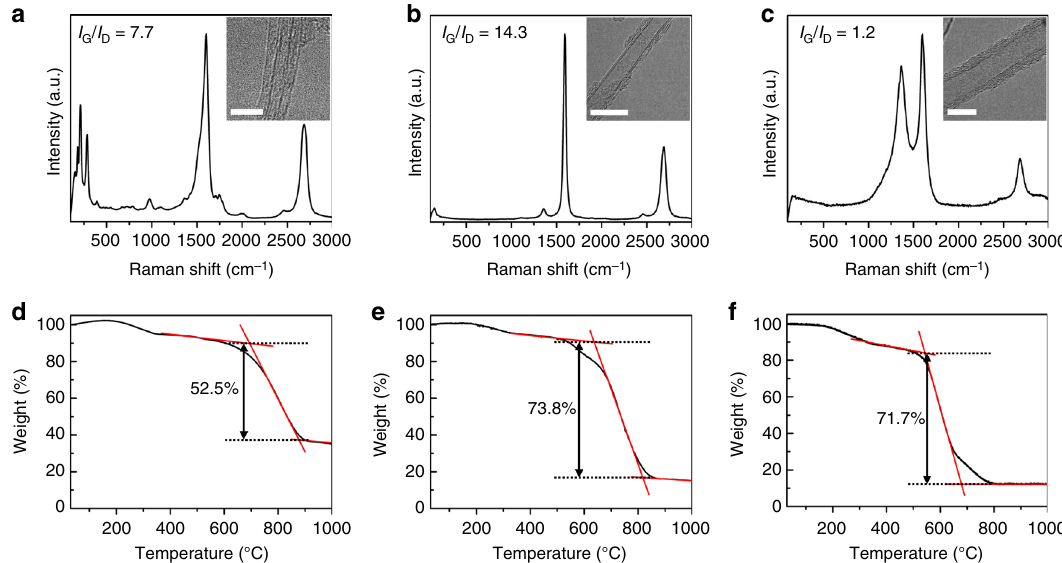
Fig. 2 Characterization of as-spun CNTFs with different types of CNTs. Raman spectra of as-spun CNTFs dominantly consisting of a SWCNTs, b DWCNTs, and c MWCNTs with corresponding TEM images displayed as insets. TGA curves of as-spun CNTFs dominantly consisting of d SWCNTs, e DWCNTs, and f MWCNTs. The scale bars in the insets of a – c are 5, 10, and 10 nm,